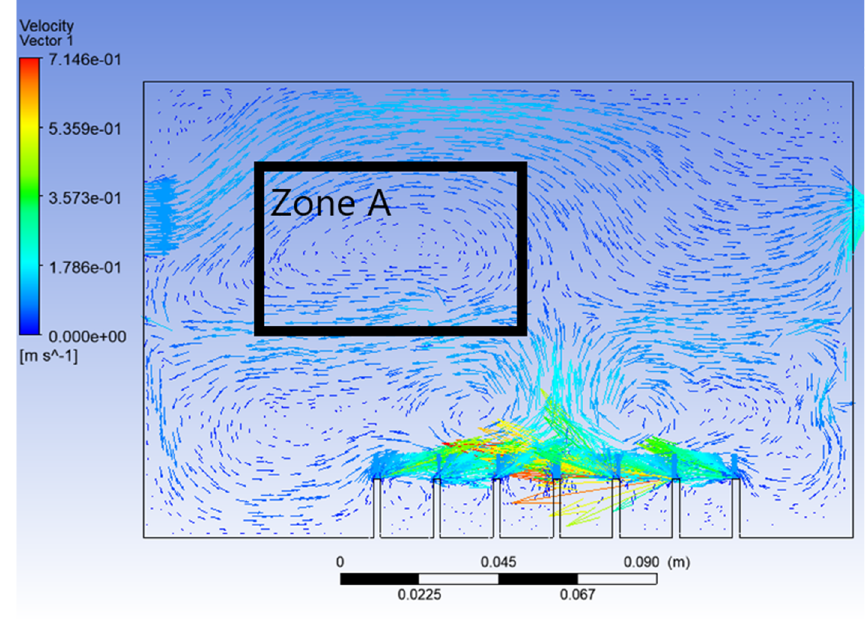
Figure 7. Velocity vector of Simulation 2.